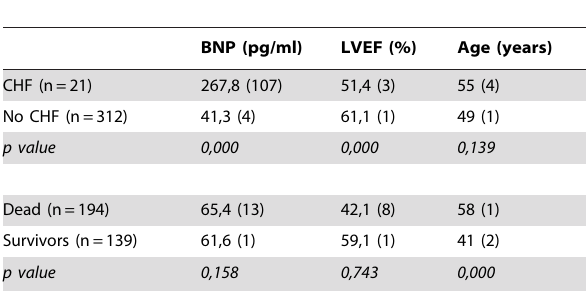
Table 1. BNP concentration and left ventricular ejection fraction (LVEF) in patients grouped according to the major end points; hospitalization for congestive heart failure (CHF) and